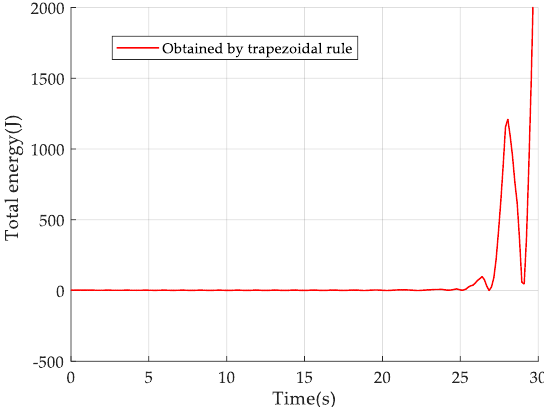
Figure 7. The energy evolution of the pendulum using the trapezoidal rule with ∆ t = 0.15 s.